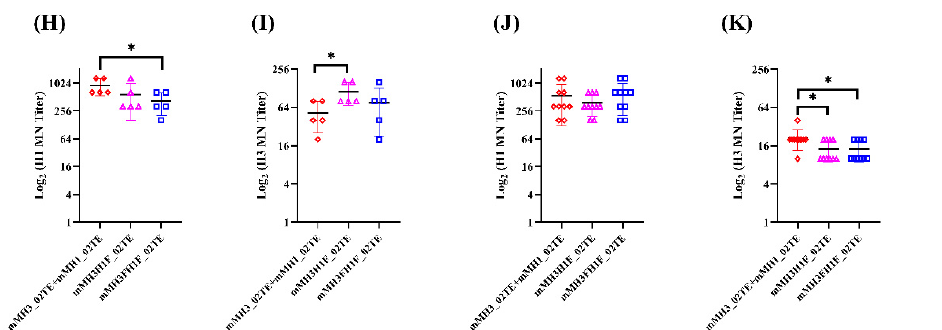
Figure 6. Immunogenicity of hemagglutinin ectofusion immunogens in mice. ( A ) Schematic representation of immunization schedule. Serum titers were obtained after two immunizations with SWE formulated immunogens. ( B , C ) ELISA endpoint titers against tagless H1 and H3 hemagglutinin ectodomains, respectively. ( D , E ) HI titers against homologous A/Guangdong − Maonan/SWL1536/2019 (H1N1) and A/Hongkong/2671/2019 (H3N2) viruses, respectively. ( F , G ) HI titers against heterologous Bel/09 and X − 31 viruses, respectively. ( H , I ) MN titers against homologous A/Guangdong − Maonan/SWL1536/2019 (H1N1) and A/Hongkong/2671/2019 (H3N2) viruses, respectively. ( J , K ) MN titers against heterologous Bel/09 and X − 31 viruses, respectively. Two − tailed Student’s t − test was performed for pairwise ELISA endpoint titer, HI titer and MN titer comparisons (* indicates p < 0.05, ** indicates p < 0.01, and **** indicates p < 0.0001).